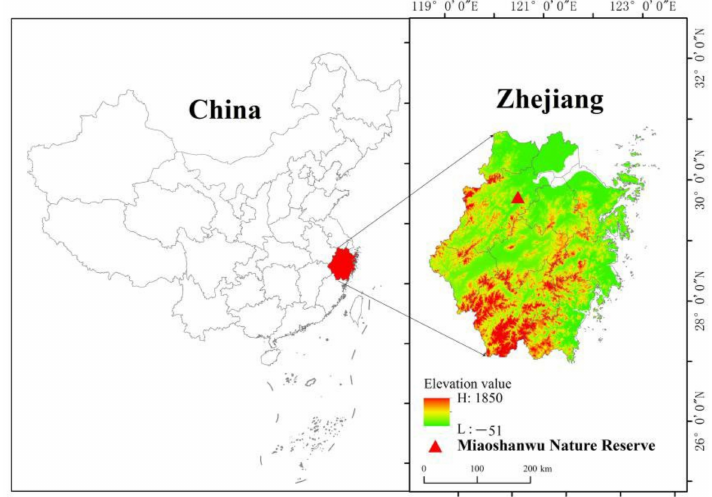
Figure 1. Location of the experimental area, Miaoshanwu Nature Reserve, Zhejiang province,